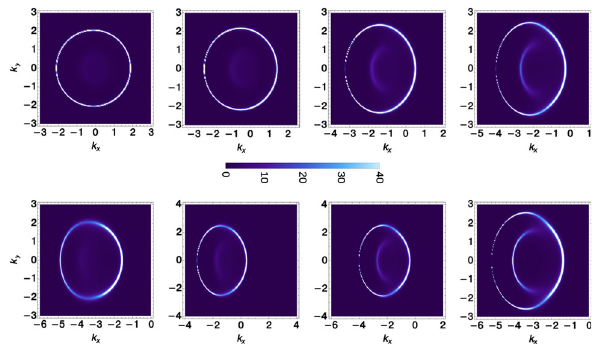
Fig. 4 Hereweplottedthespectraldensitywithfermionmass m ψ = 0 and charge q = 1. In the top panel, we fixed T /μ = 0 . 009,coupling p 2 = 1 . and vary source χ ( 1 ) = ( 0 . 5 , 1 . 0 , 1 . 5 , 1 . 8 ) with k 1 /μ = 0 . 2, k 2 /μ = 0 . 8, and m 2 φ = 0 respectively. In the bottom panel, we vary the coupling p 2 taking values p 2 = 0 . 1 , 0 . 5 , 0 . 8 , 1 . 2 while we fixed χ ( 1 ) =